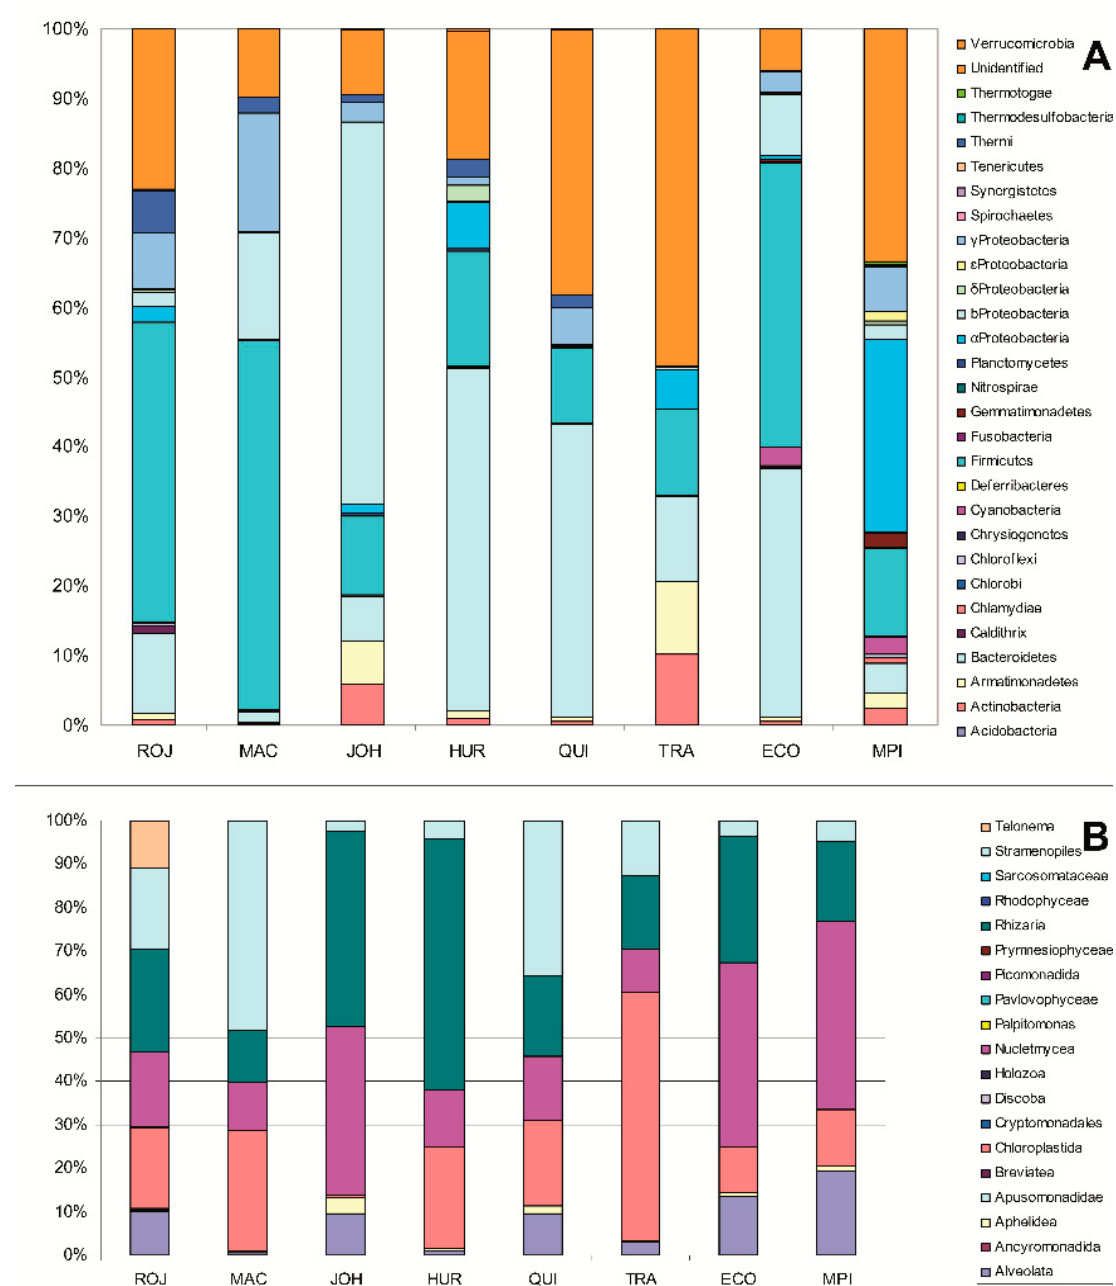
Figure 2. Composition of microbial communities. Relative abundances of major taxa of ( A ) bacteria and ( B ) microeukaryotes in the englacial ecosystem based on 16S and 18S rRNA gene sequenc- ing.